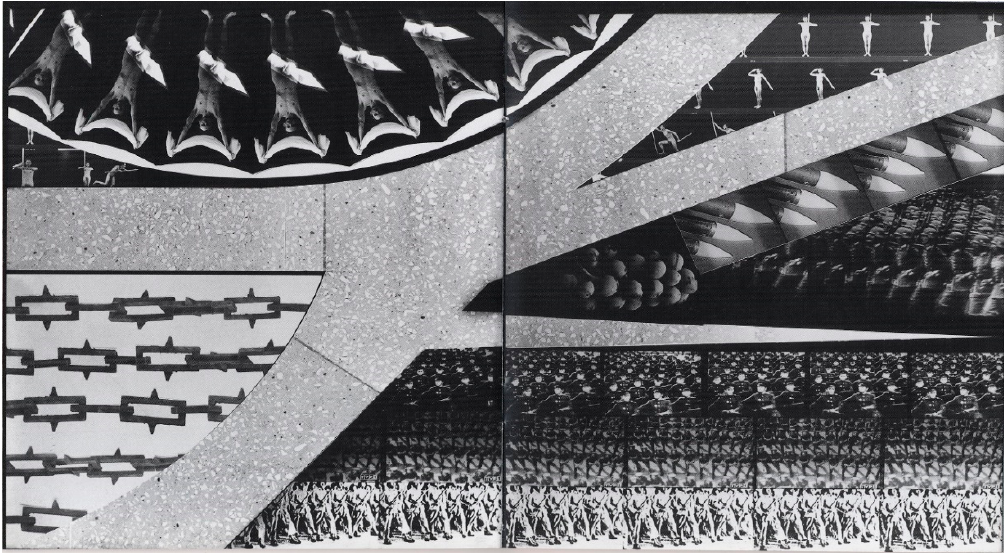
Figure 5. Kulik, guide , 1997. Marching soldiers.